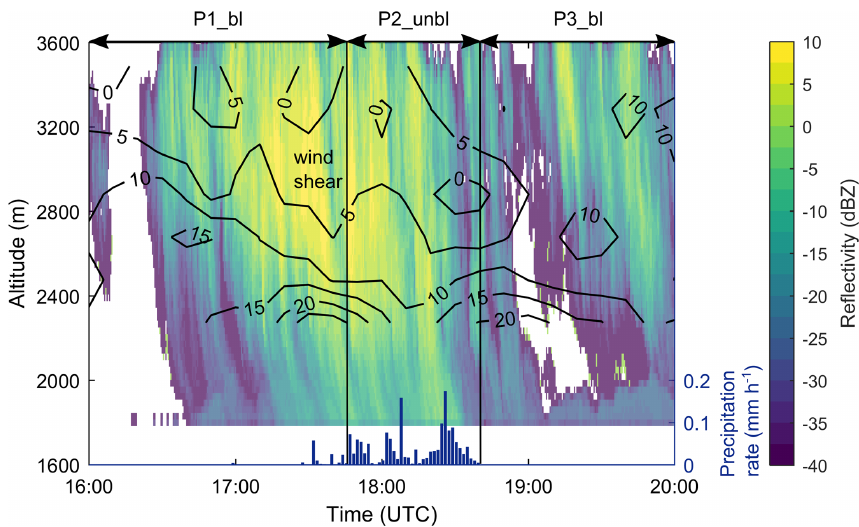
Figure 9. Temporal and spatial evolution of the vertical wind shear (in ms − 1 km − 1 ; black contour lines), the radar reflectivity (colored area) and the precipitation rate (blue bars). The wind shear was calculated from the wind profiler observations (Fig. 5), and the precipitation rate was measured with a disdrometer at Wolfgang (1630m).